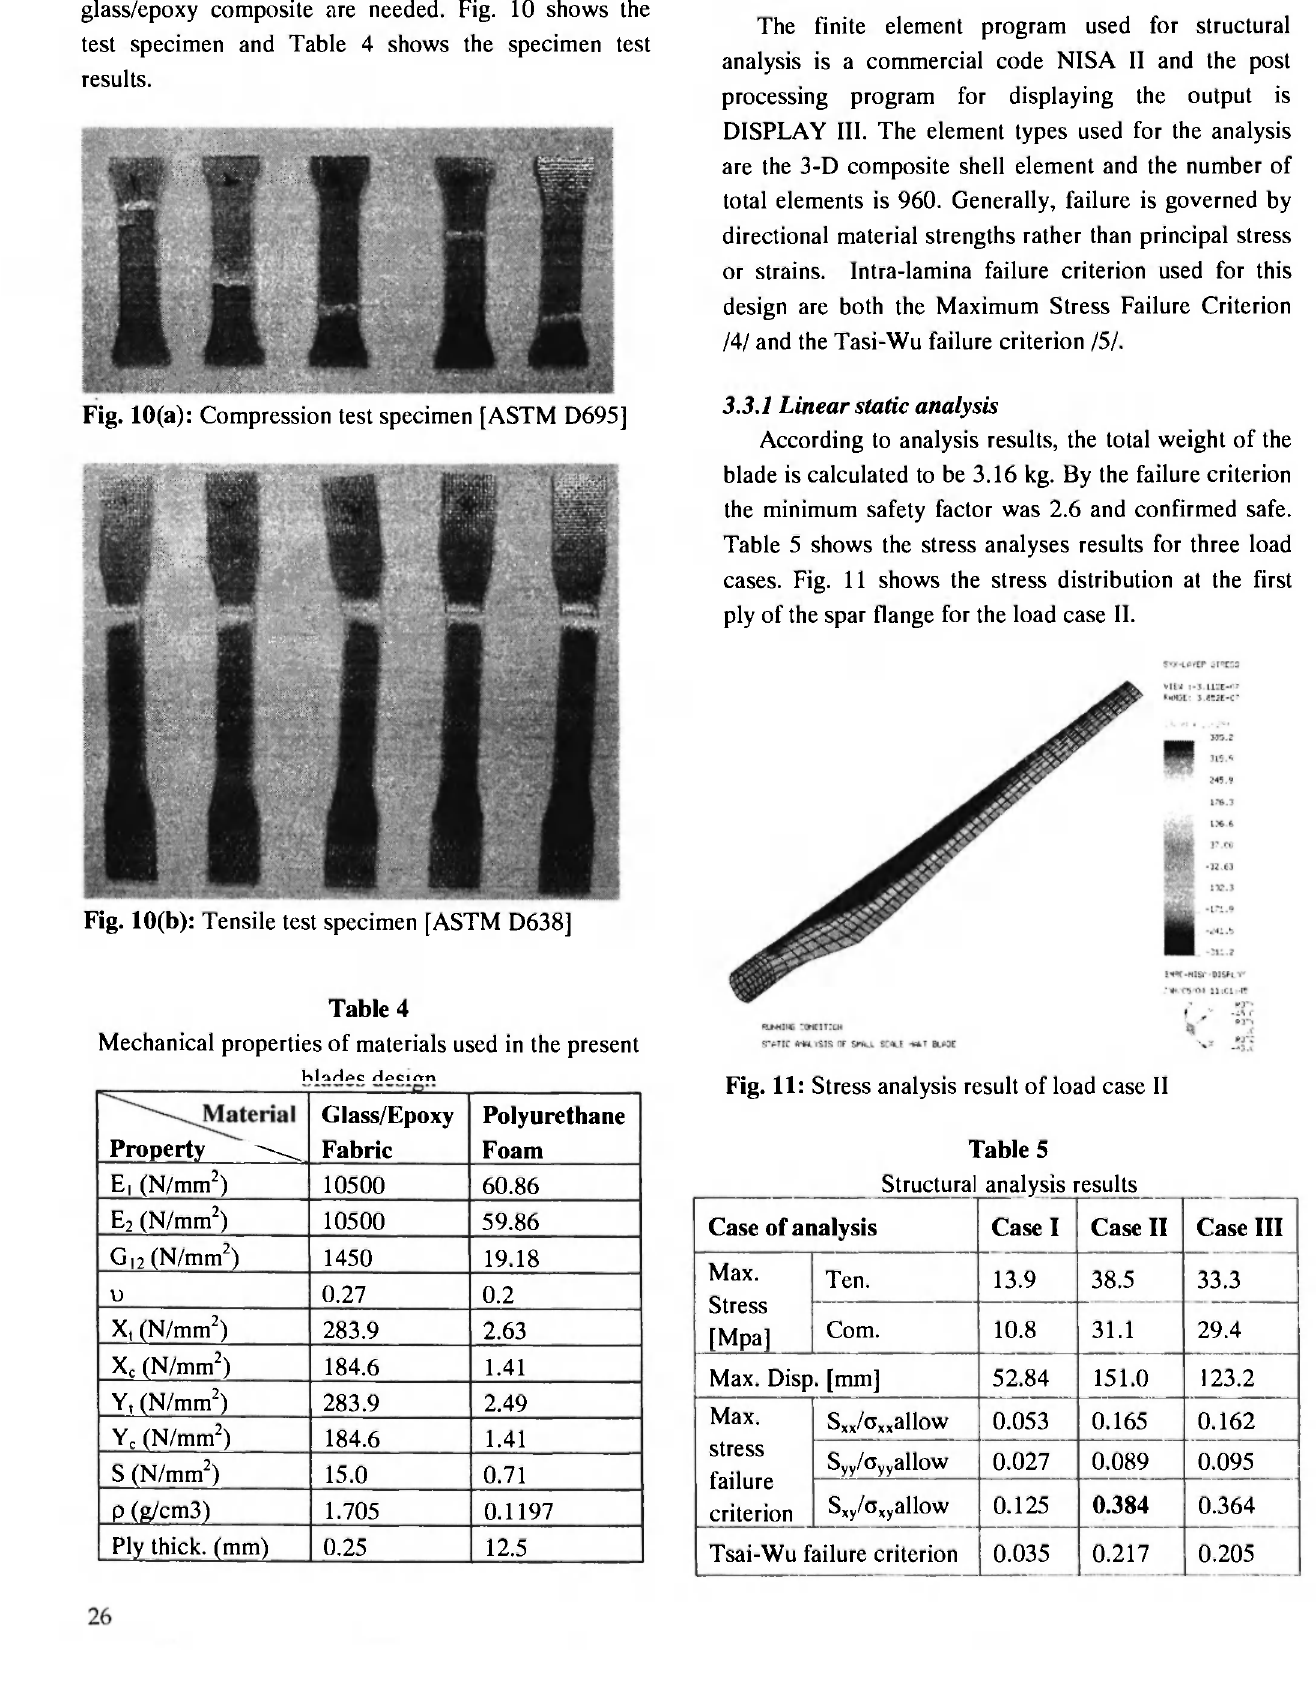
Fig. 10(b): Tensile test specimen [ASTM D638]